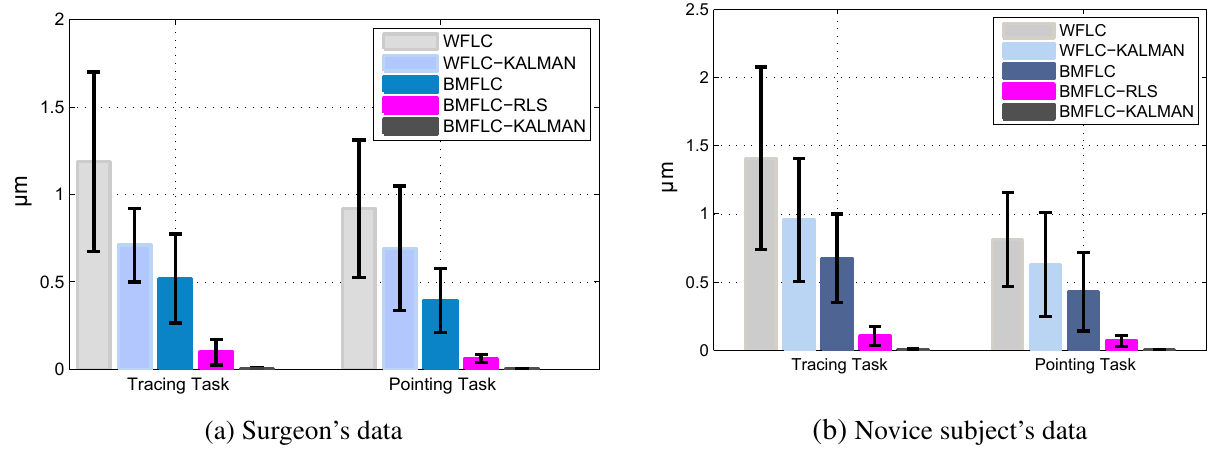
Figure 8. Average RMS tracking error ( µm ) for all algorithms with tracing and pointing tasks; error bars represent standard deviation around